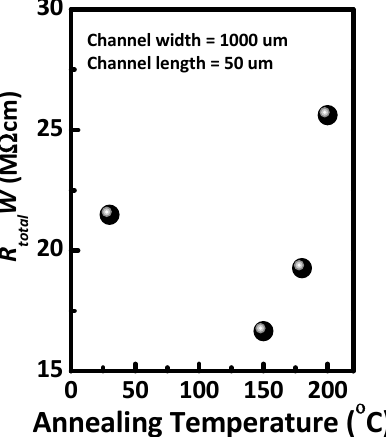
Figure 3. ( a ) Out-of-plane and ( b ) in-plane XRD patterns of the PQCTQx fi lms. Channel resistance data were also collected for the various OFET devices. The channel